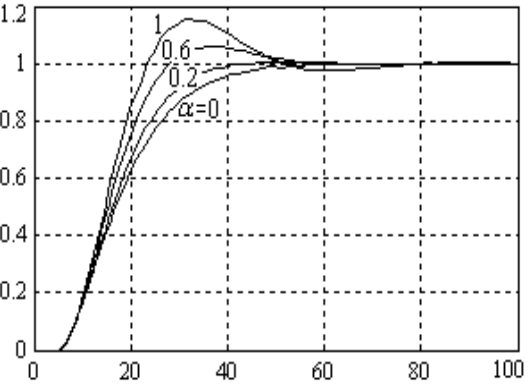
Figure 5. Responses y ( t ) to a unit step reference for process (31), G M ( s ) = G P ( s ) , K = 2, and α = 0; 0.2; 0.6;